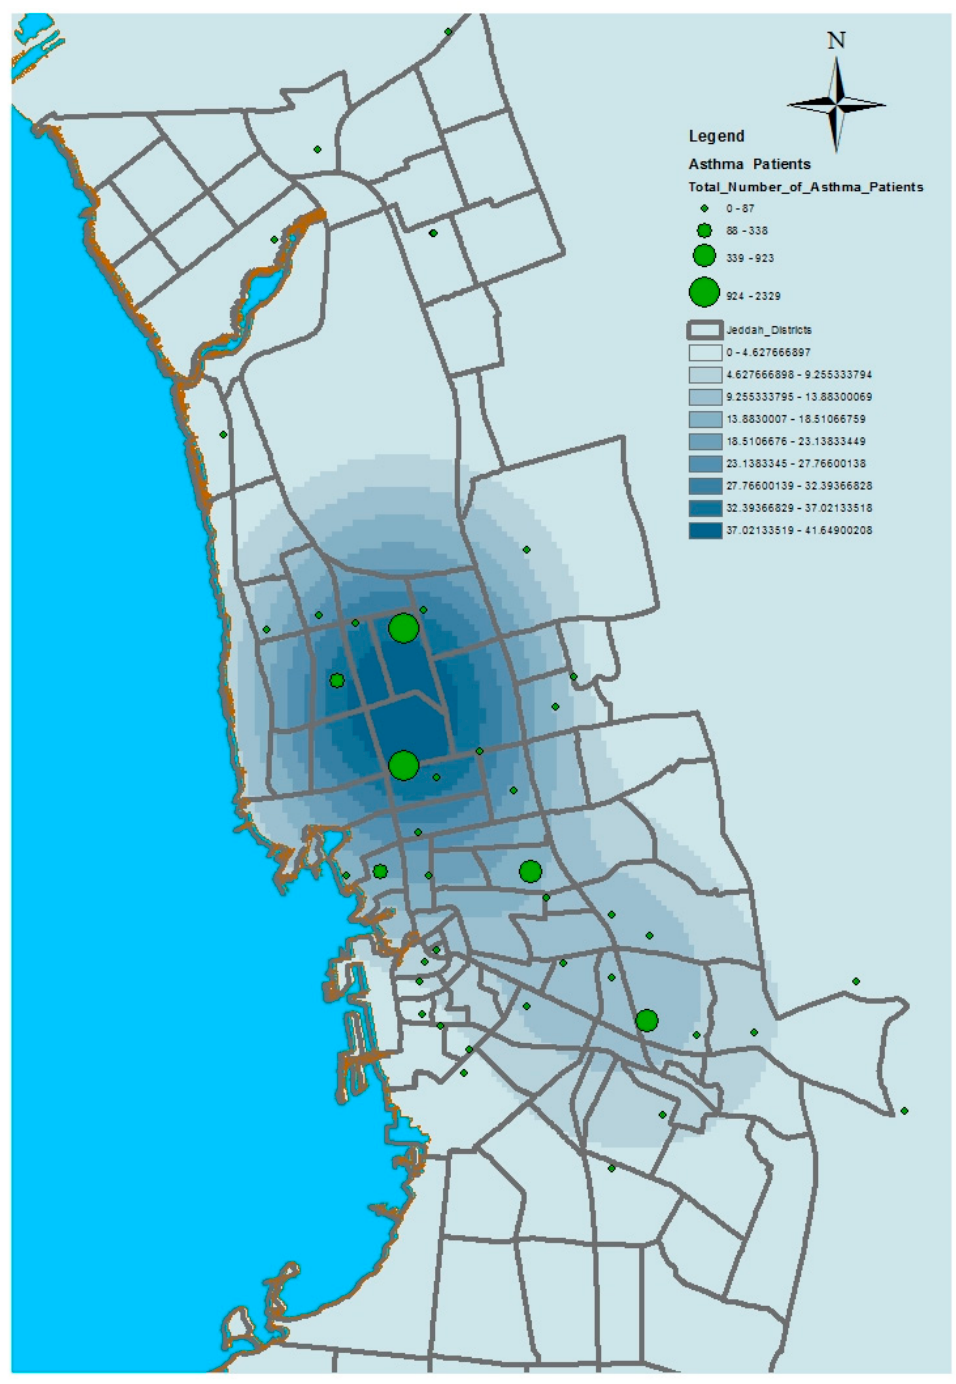
Figure 7. Kernel density for asthma patients.